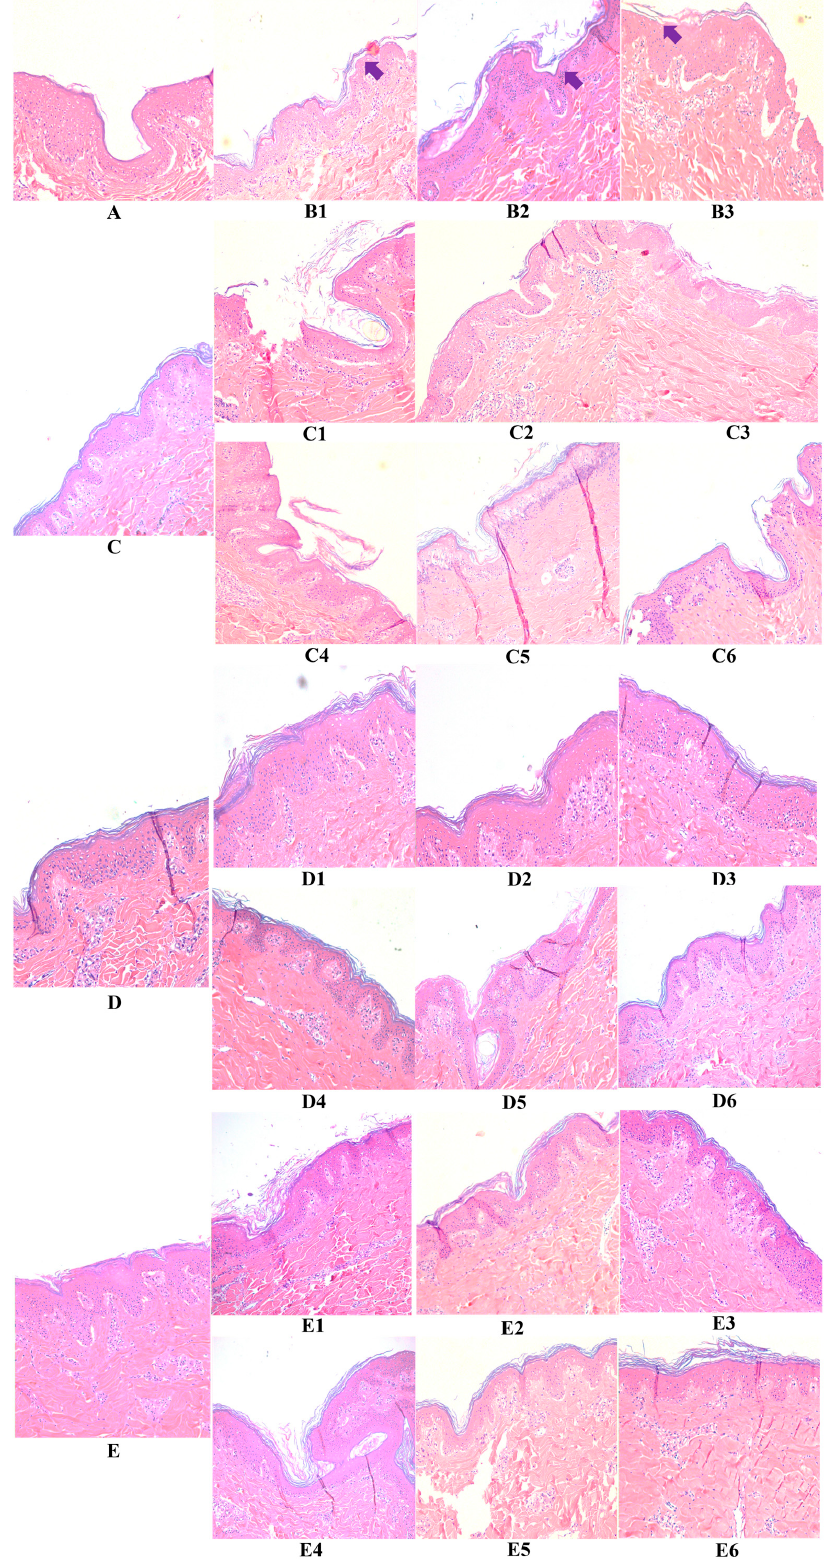
Figure 3. 10 × magnification eosin-hematoxylin stained tissues after 48 h infection with Staphylococcus aureus ATCC29213 and DSM20491 ( panels B1 , B2 ), FCS ( panel B3 ), untreated ( panel A ) and treated (pre-incubated and coincubated) tissues with HA (panels C1 – C6 ), c40 ( panels D1 – D6 ) and HAc40 ( panels E1 – E6